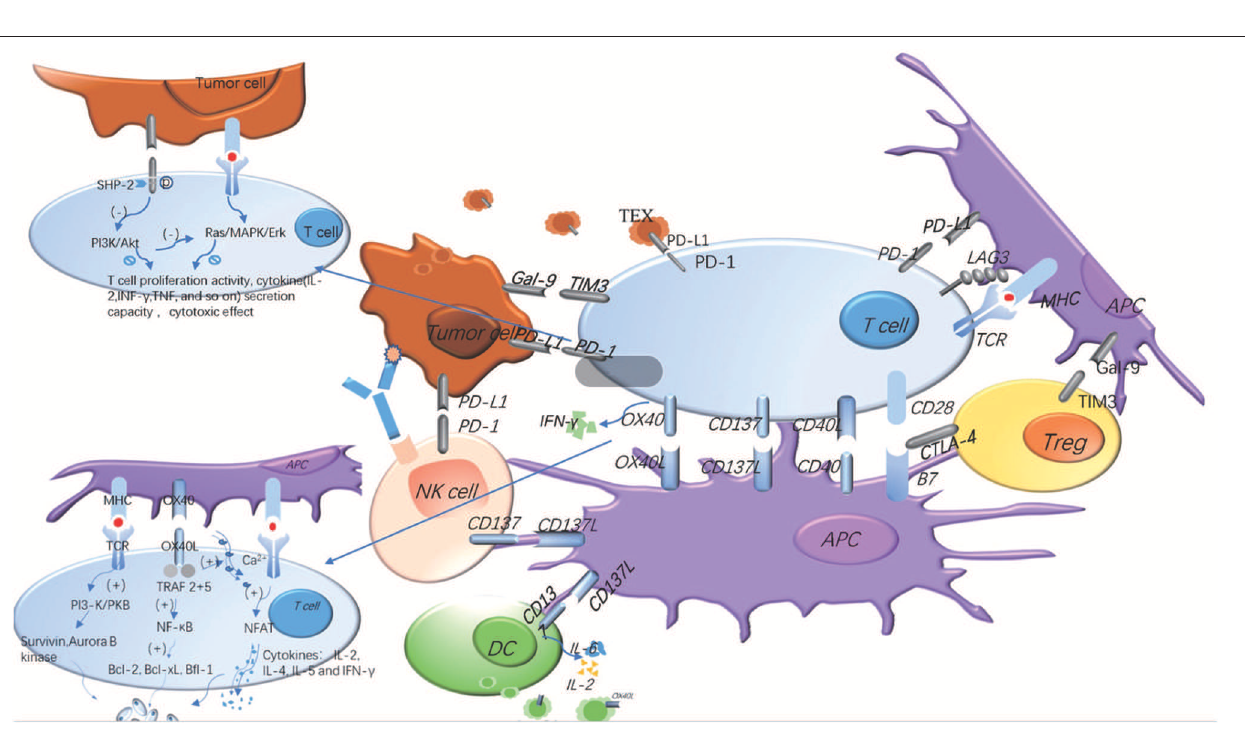
FIGURE 2 | Costimulatory and coinhibitory signal molecules can be expressed on different cell surfaces and play different roles. In the process of T cells’ immune response to tumors, costimulatory and coinhibitory signal molecules regulate the immune response in opposite ways. The same signal molecules may exist on the different cell surface, and the same cell surface may express many different signal molecules. The adding of TEX and soluble molecules makes the regulation of the whole immune response more complex. The blue represents the costimulatory molecules, and the gray represents the coinhibitory molecules. The signaling pathways of OX40 and PD-1 are explained in the